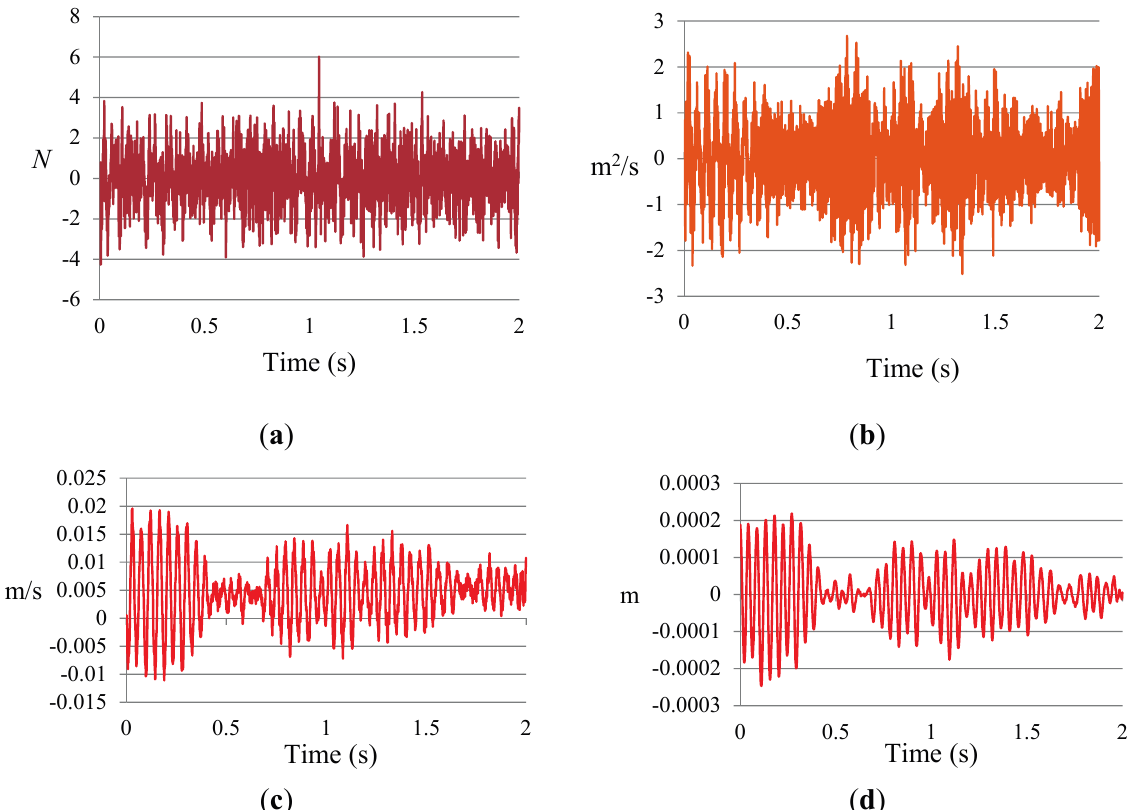
Figure 13. Input and structural response data at location 3 of Case 1: ( a ) force; ( b ) acceleration; ( c ) velocity; ( d )